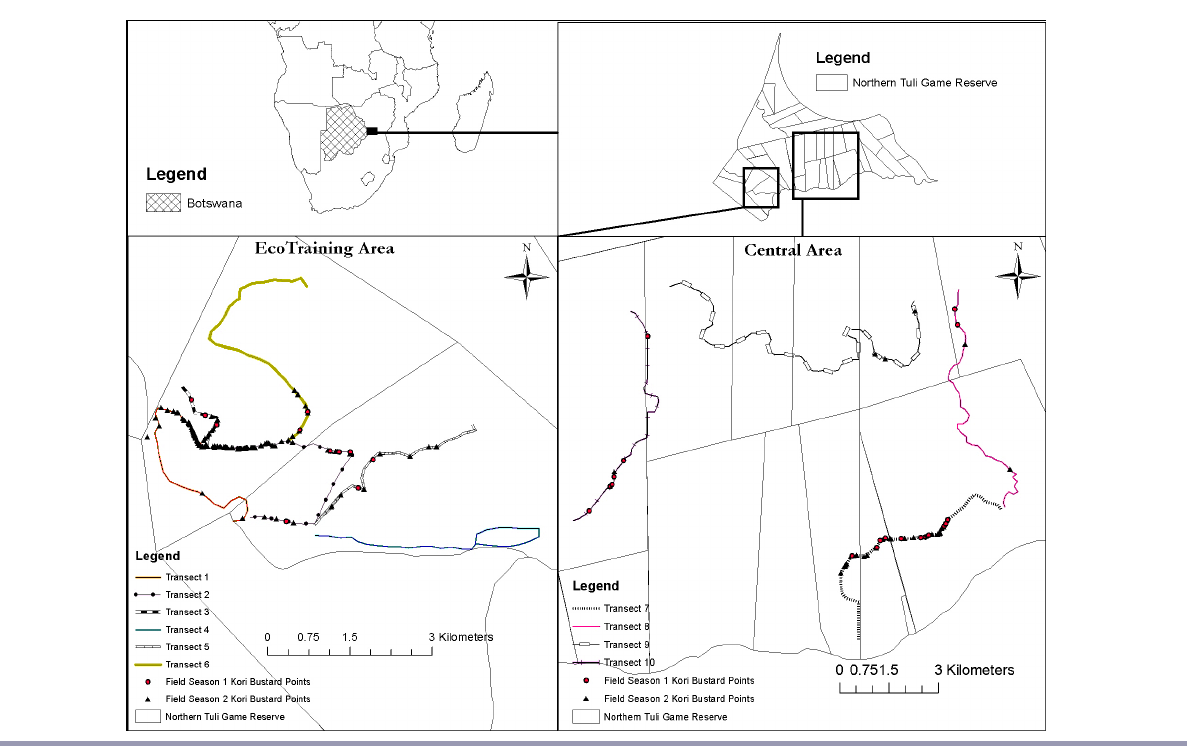
Fig. 1 . Kori Bustard ( Ardeotis kori ) detection points throughout the Northern Tuli Game Reserve, Botswana from June–July 2014 and May–July 2015. Two specified areas, EcoTraining and Central, were the only regions sampled.